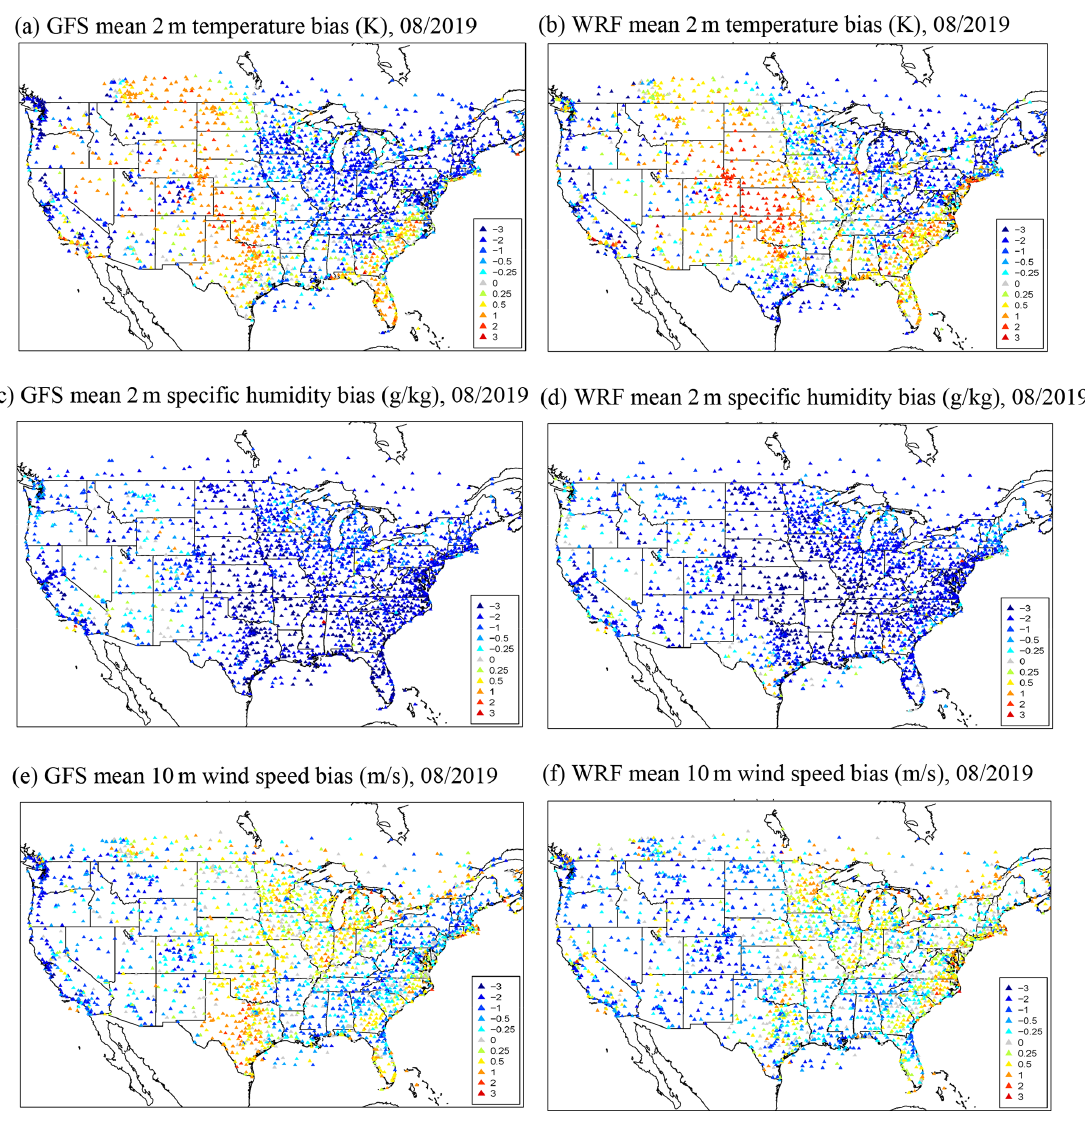
Figure 1. GFS and WRF surface meteorological biases for METAR (METeorological Aerodrome Report) stations averaged over Au- gust